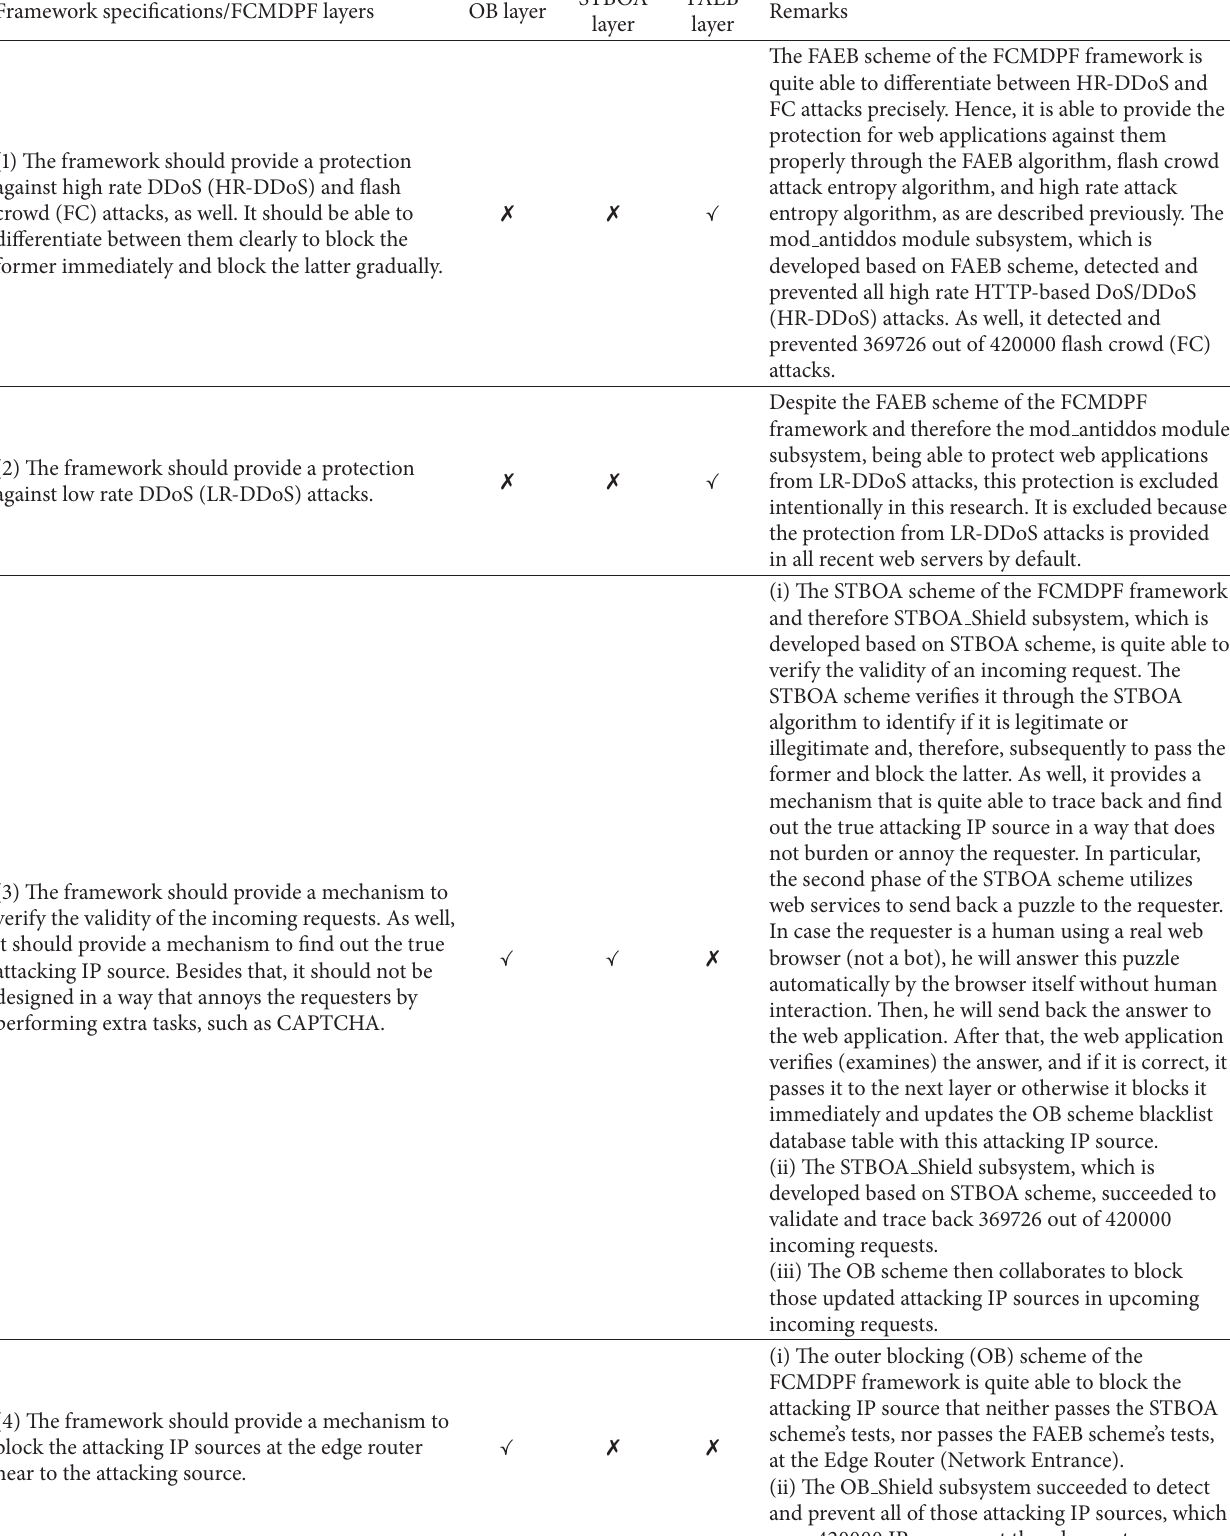
Table 2: Evaluating FCMDPF framework based on the optimal specifications for a protective framework to protect web applications from all sorts of HTTP-based DoS And DDoS